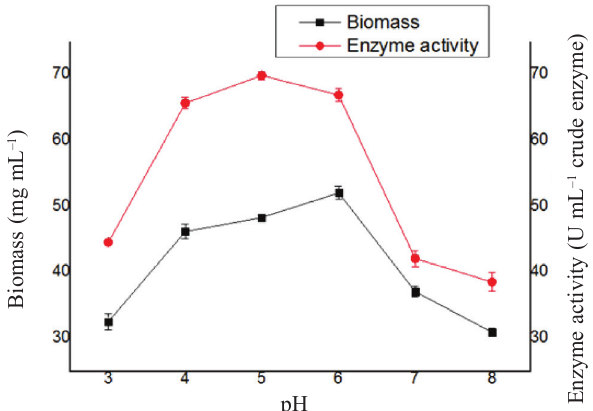
Fig. 3 – Effect of pH on enzyme fermentation performance